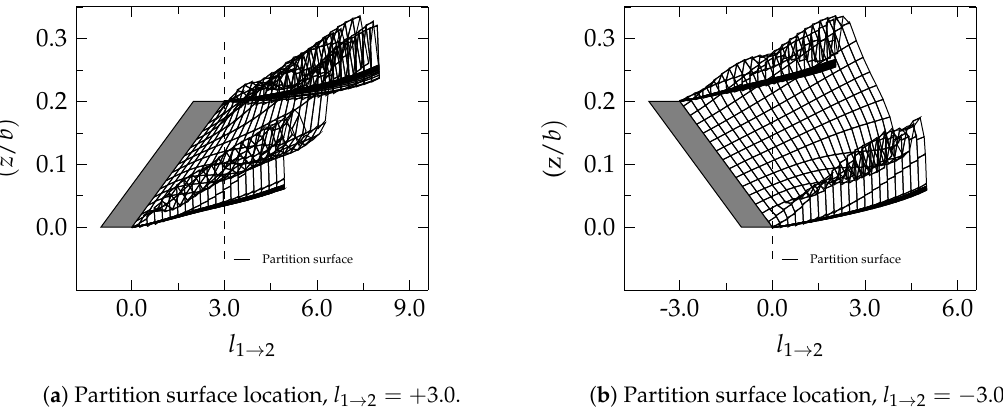
Figure 5. Wake trace